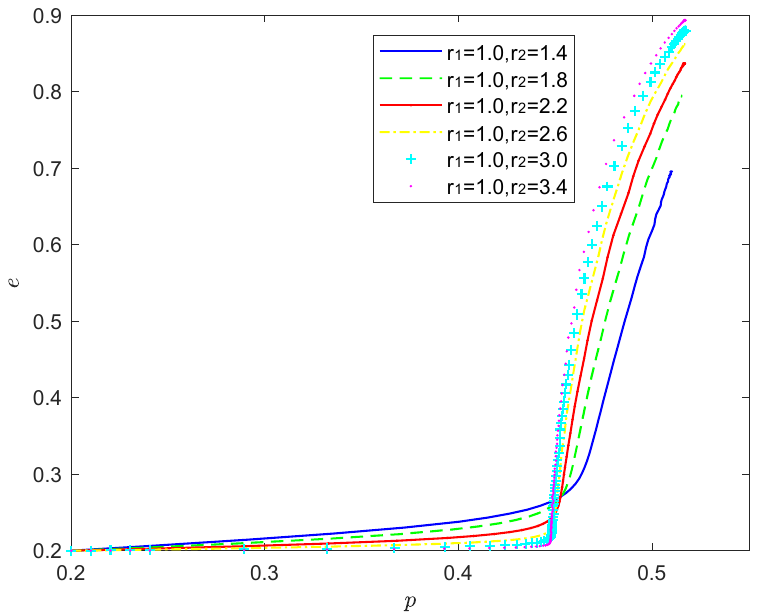
Figure 11. Evolution of game strategy in (rational, pessimistic) state.